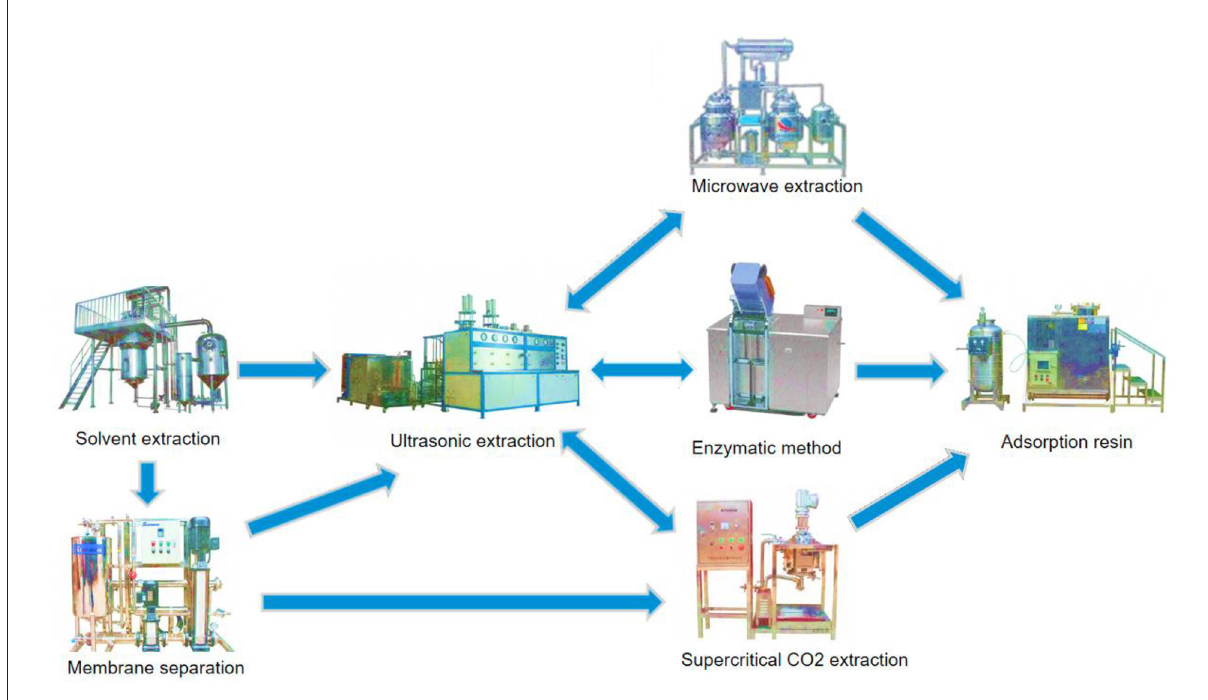
FIGURE5 Improved schematic diagram showing the extraction